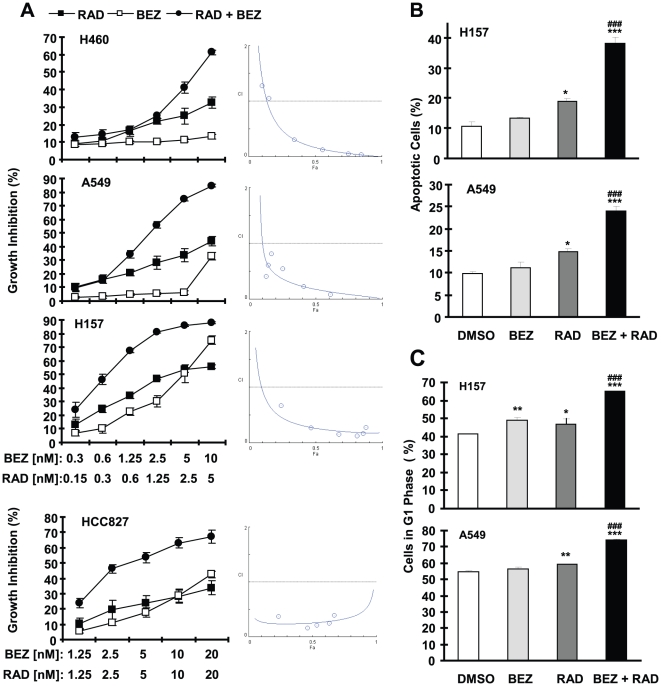
The combination of BEZ235 and RAD001 synergistically inhibits cell growth (A) and induces apoptosis (B) and cell cycle arrest (C) in NSCLC cells.
A, the indicated cell lines were seeded in 96-well plates and then treated next day with different concentrations of BEZ235 (BEZ), RAD001 (RAD) and their respective combinations as indicated. After 3 days, the cell numbers were estimated using the SRB assay and CIs were calculated with CompuSyn software (right panels). Points, means of four replicate determinations; bars, ± SD. B and C, The indicated cell lines were seeded in 6-well plates and then treated with 10 nM BEZ235 alone, 2 nM RAD001 alone, and their combination. After 48 h, the cells were harvested for detection of apoptosis using Annexin V staining (A) and for cell cycle analysis with a flow cytometry (C). Columns, means of duplicate determinations; Bars, ± SD. *, P<0.05, ** P<0.01, and ***, P<0.001 compared with DMSO control; ###, P<0.001 compared with RAD001 or BEZ235 alone.